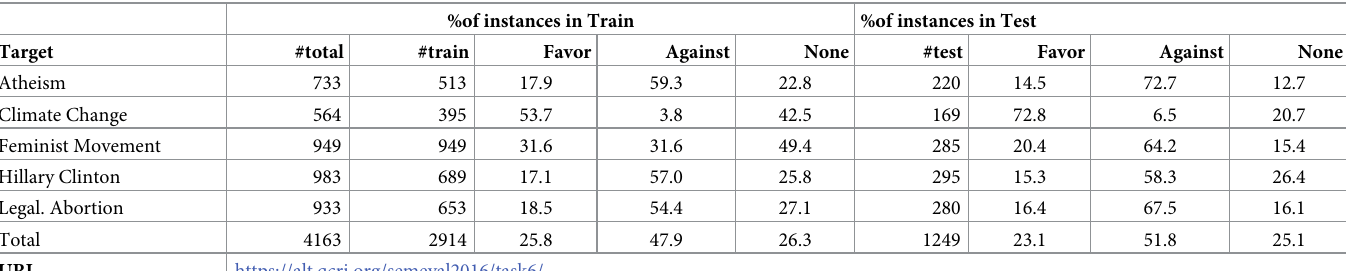
Table 2. The SemEval-2016 stance dataset.